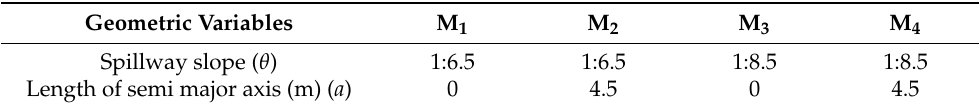
Figure 2. ( a ) Layout plane of the experimental setup. ( b ) Definition sketch for semi-major axis of spillway pier. Table 1. Detail of geometric modifications.